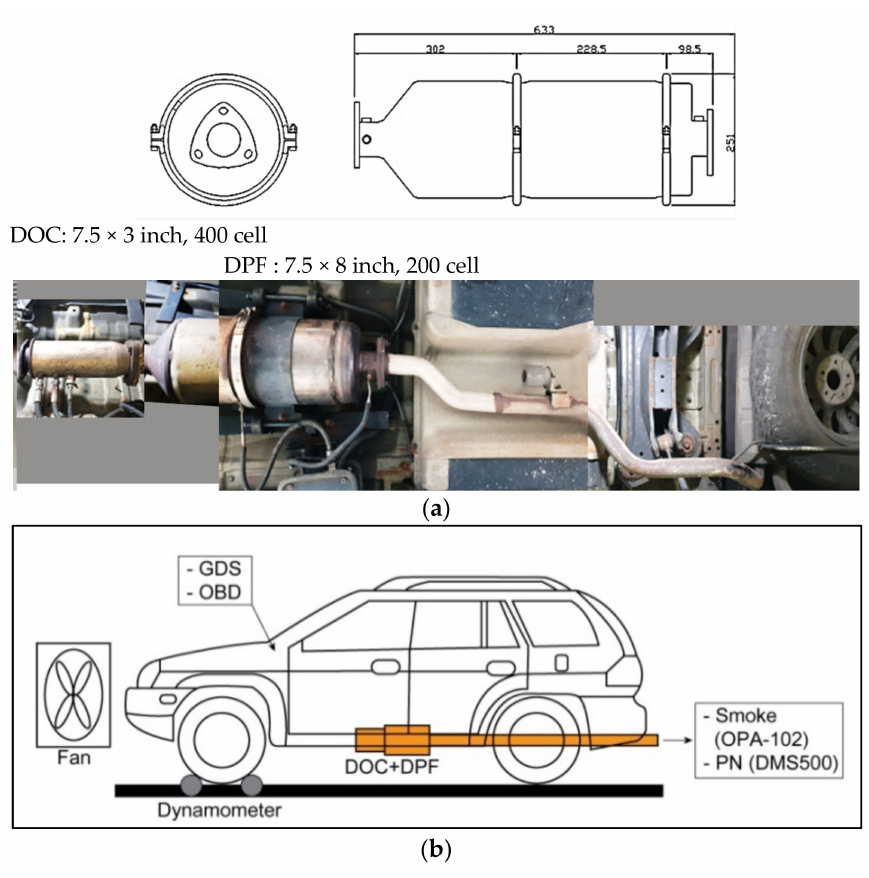
Figure 2. Vehicle experimental schematic with after-treatment device. ( a ) Exhaust system with DPF device; ( b ) Schematic of vehicle after-treatment system.